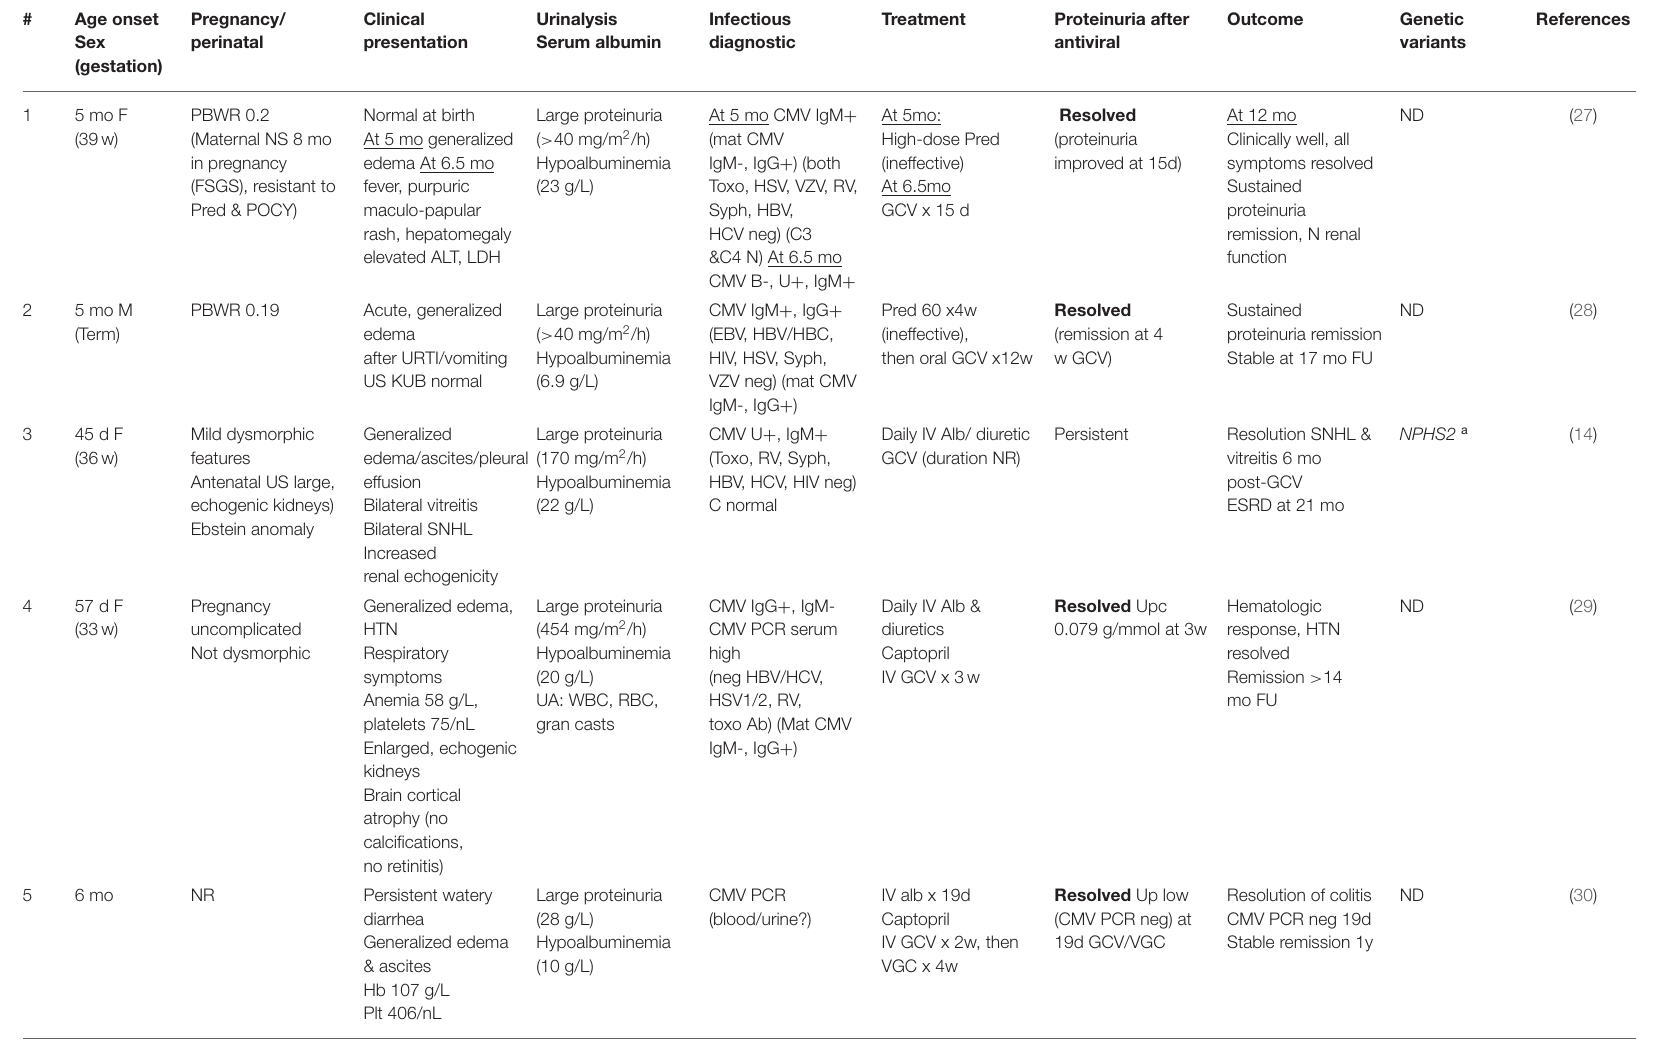
TABLE 2 | CMV-associated congenital and infantile nephrotic syndrome (Literature review and